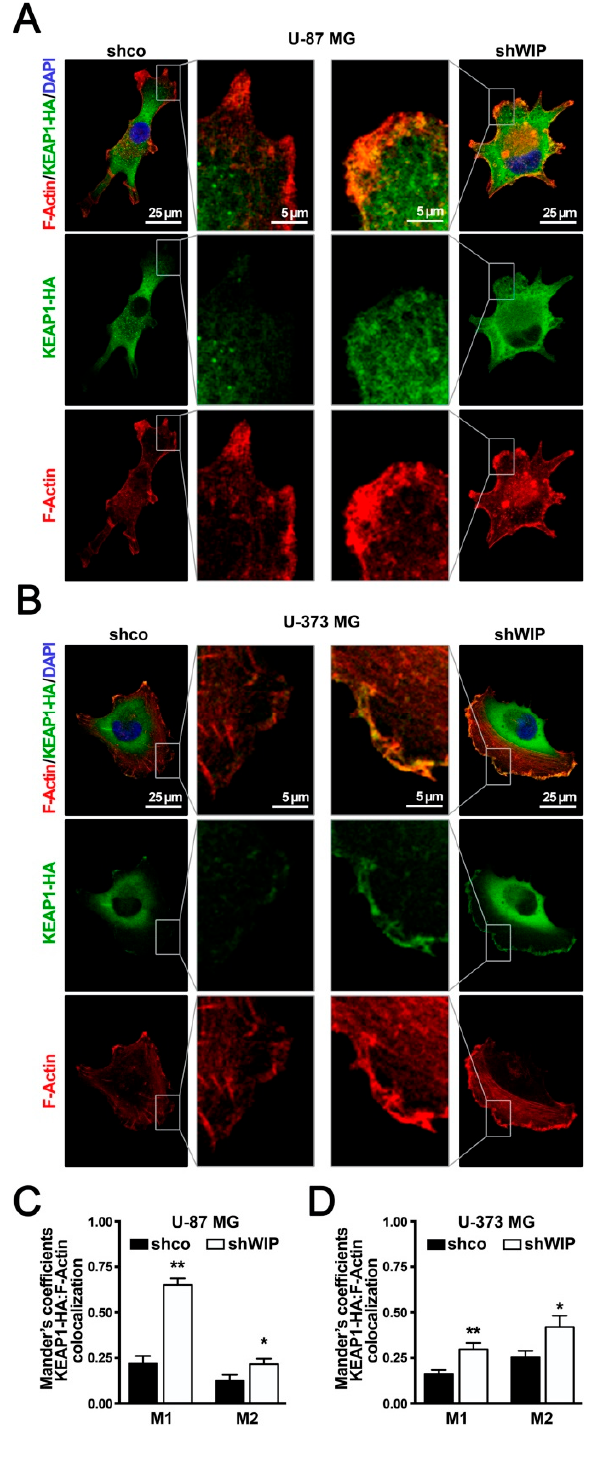
Figure 5. WIP knocked-down cells exhibit increased co-localization between KEAP1 and F-Actin. U-87 MG ( A , C ) and U-373 MG ( B , D ) glioblastoma cells were transduced with lentivirus expressing KEAP1-HA and then with a lentivirus expressing shco or human shWIP. ( A , B ) Immunostaining of KEAP1 with HA antibody and counterstaining with Phalloidin and DAPI to show F-Actin and nuclei, respectively. ( C , D ) Quantification of colocalization between F-Actin and KEAP1-HA expressed as Manders’ overlap coefficients. Fluorescence was quantified in 1 µm-thick stacks using the JACoP plugin of ImageJ software. Data are presented as mean ± S.E.M. ( n = 20) * p ≤ 0.05, ** p ≤ 0.01 according to one-way ANOVA.